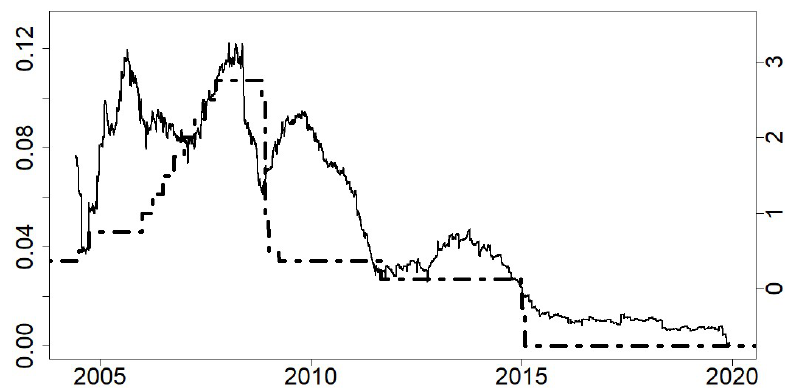
Figure 1. Left axis: Proportion of capital protected products among all investment products and interest rate levels from 2004 to 2019. Right axis: Swiss policy interest rate